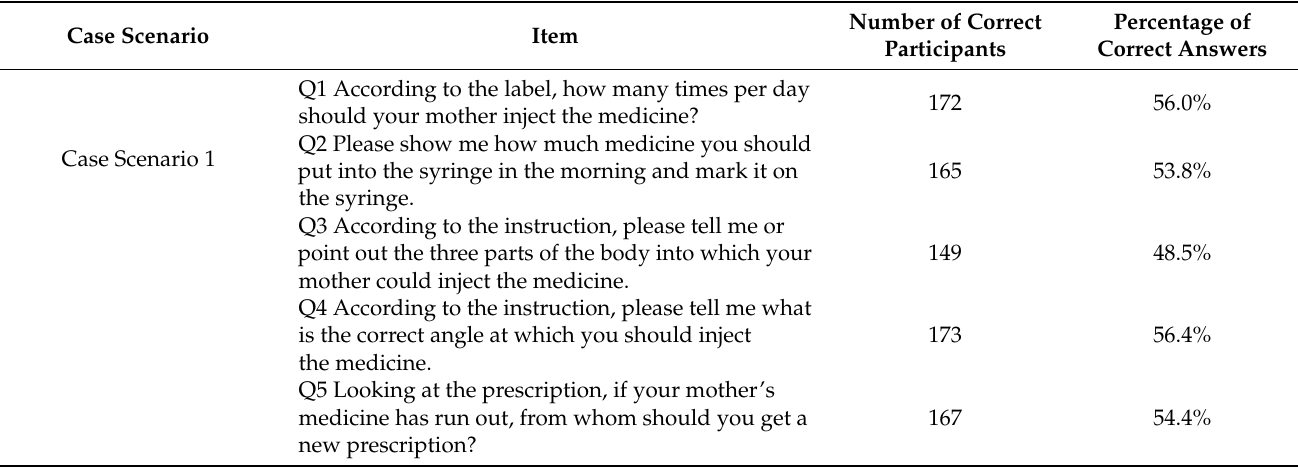
Table 2. Medication literacy by case scenario for patients with